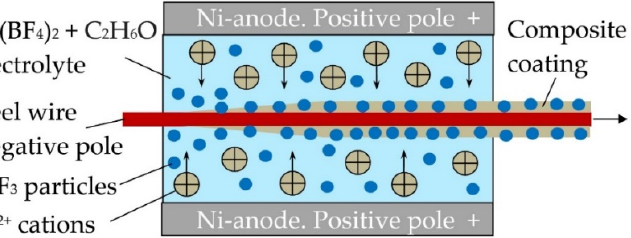
Figure 2. The principle of electrochemical formation of a composite coating on the surface of the wire.